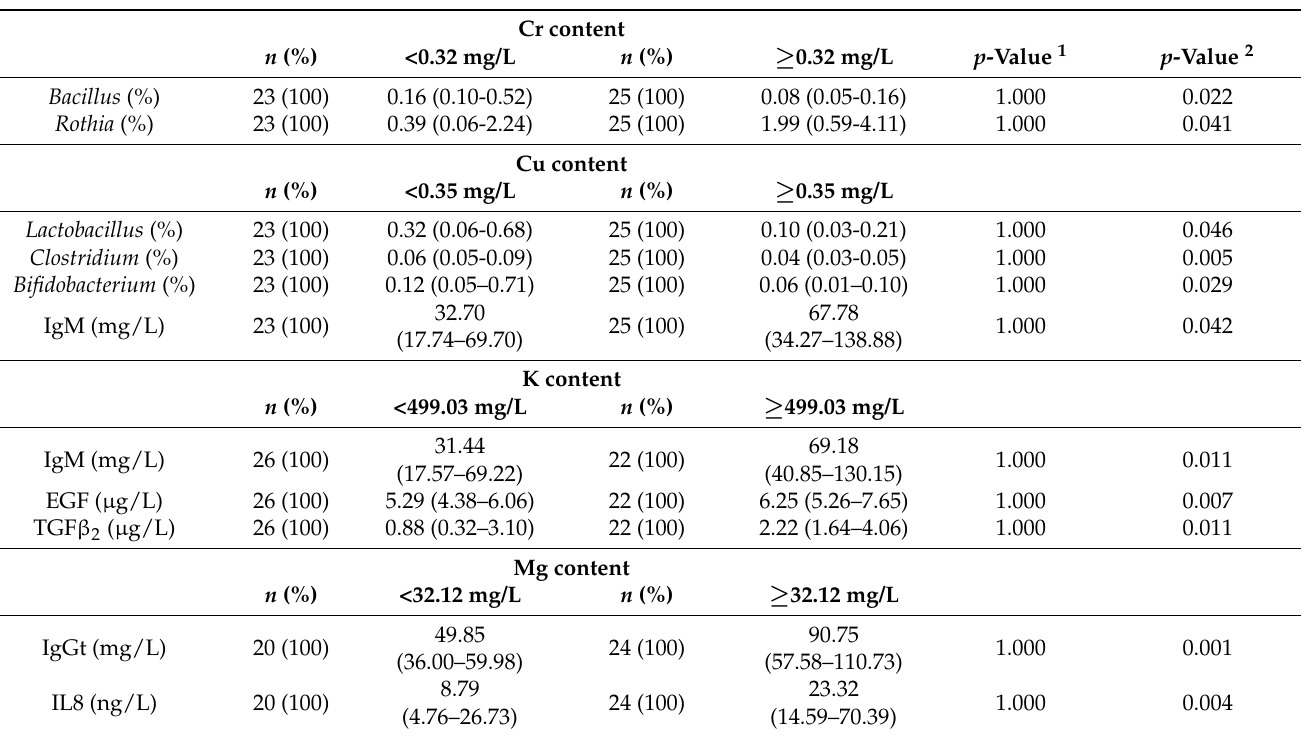
Table 5. Differences in the prevalence and concentration of microbial relative abundances obtained after metataxonomic analysis and immunological compounds according to the content of main elements in milk